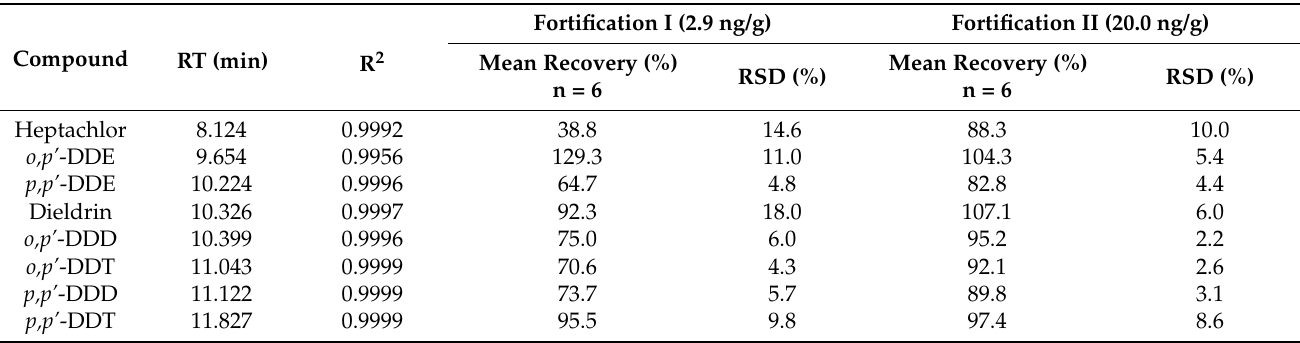
Table 2. Analyst 2 method validation parameters.